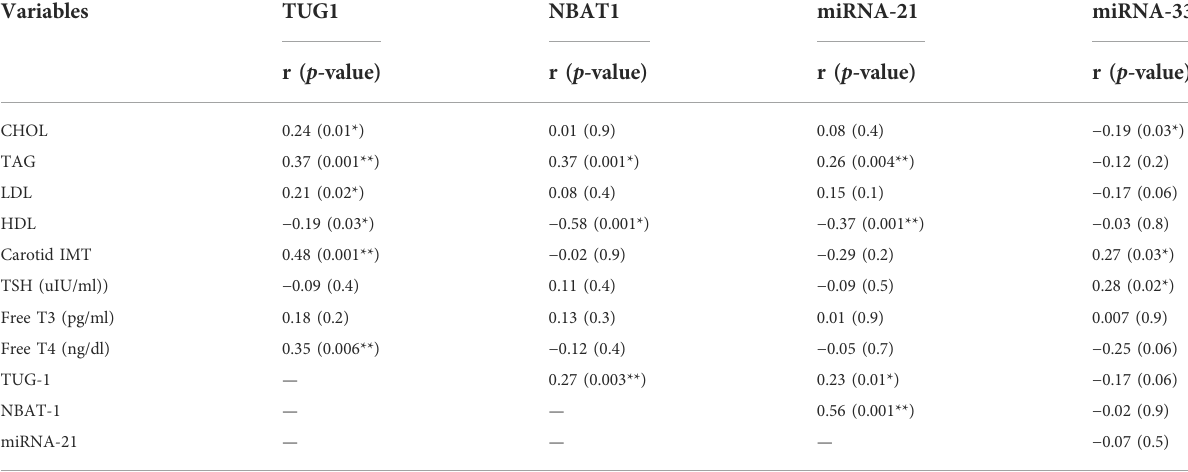
TABLE 6 Correlation between biomarkers and study variables among cases. Variables